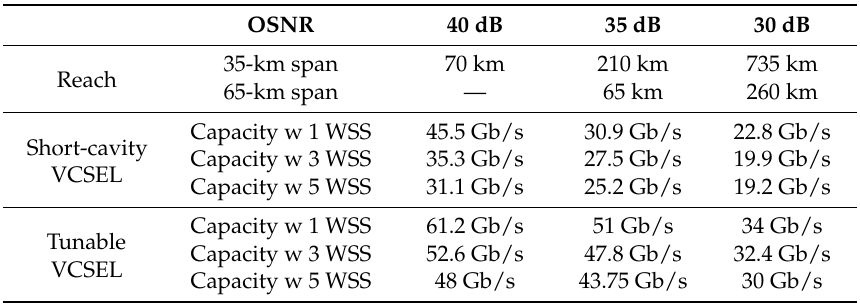
Table 3. Transmitted capacities and SSMF reach for DSB DMT as a function of: span length, VCSEL type/chirp, and number of crossed